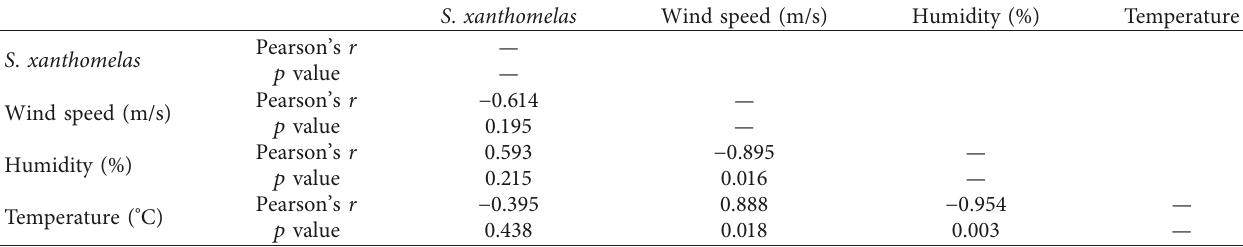
Table 7: Correlation matrix of daily ADT of S . xanthomelas with weather